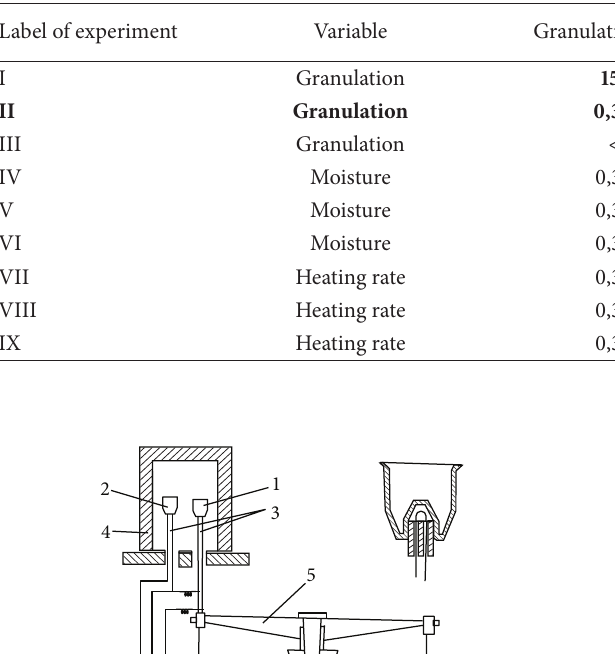
Table 3: Experimental map.